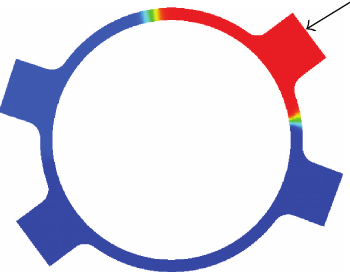
Figure 9: Temperature distribution in the horizontal inlet nozzle plane, SST model.